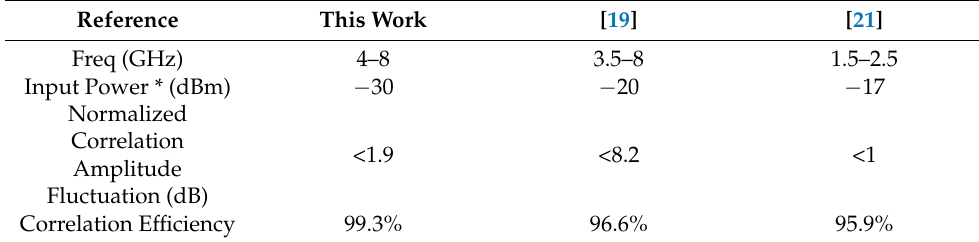
Table 2. Comparison table of the analog complex